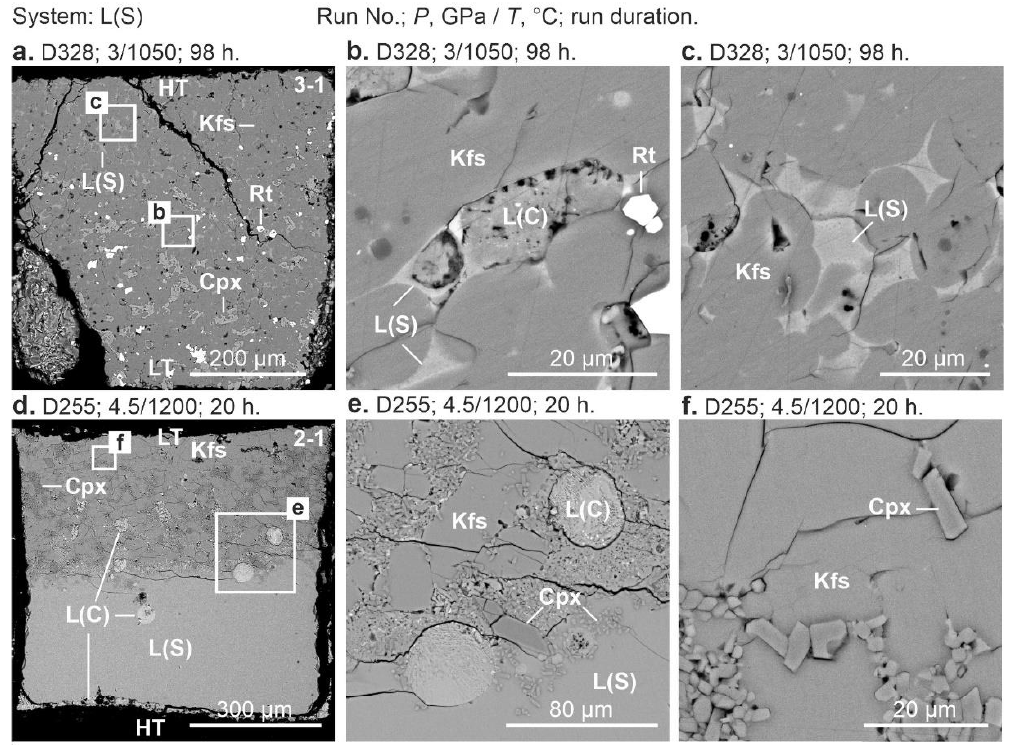
Figure 6. BSE of sample cross-sections in the system L(S) at 3 – 4.5 GPa: ( a – c ) 3 GPa, 1050 °C (run D328, 98 h); ( d – f ) 4.5 GPa, 1200 °C (D255, 20 h). See the Figure 1 caption for other details.